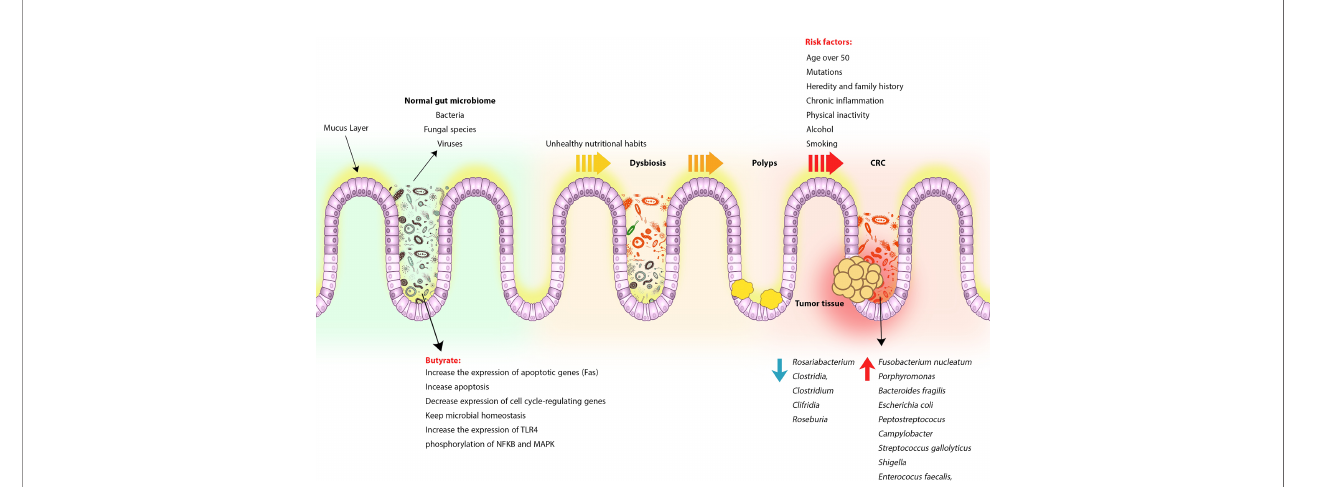
FIGURE 1 | CRC formation process following gut microbiome change and dysbiosis. Normally, the gut microbiome, made up of bacteria, viruses, and fungi, contributes to intestinal homeostasis and immune regulation by producing bene fi cial metabolites such as butyrate and SCFA, but following a change in lifestyle and poor eating habits, consuming high-fat and low- fi ber foods, red meat and processed foods alter the intestinal microbiome pattern and replace harmful and tumorigenic species. Dysbiosis can lead to chronic in fl ammation, polyps, and eventually CRC. However, other risk factors can also play a role in increasing the risk of developing